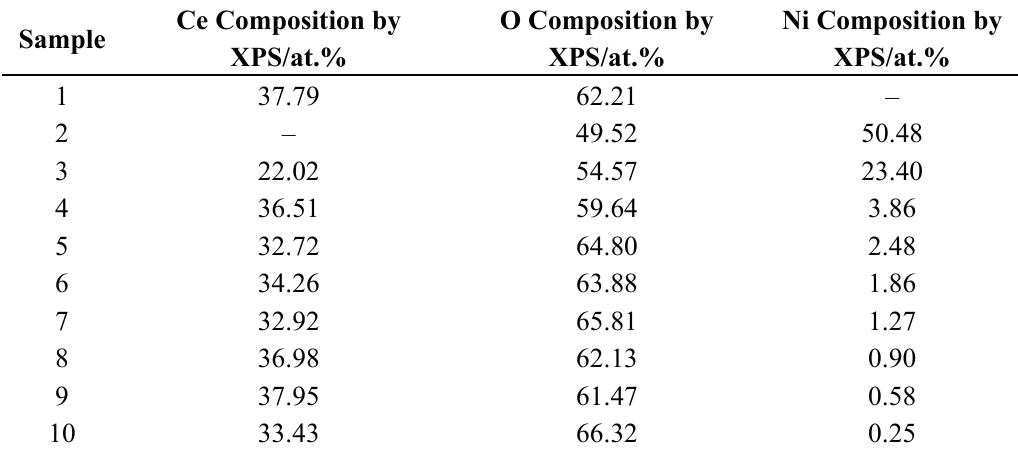
Table 2. Nanoparticle compositional analysis by quantitative XPS